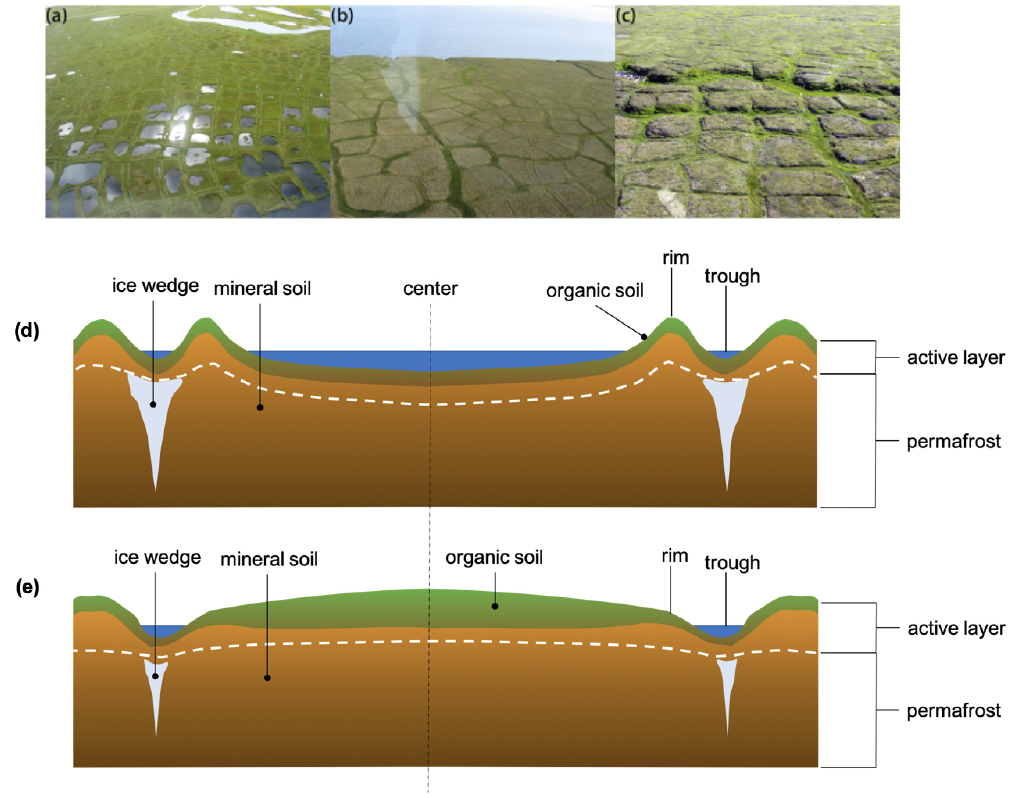
Figure 2. Examples of typical low (a) , flat (b) and high-centered (c) polygons as seen along the Yukon coast (adapted from Fritz et al., 2016). Schematic of a low-centered polygon (d) and high-centered polygon (e) (adapted from Fritz et al.,